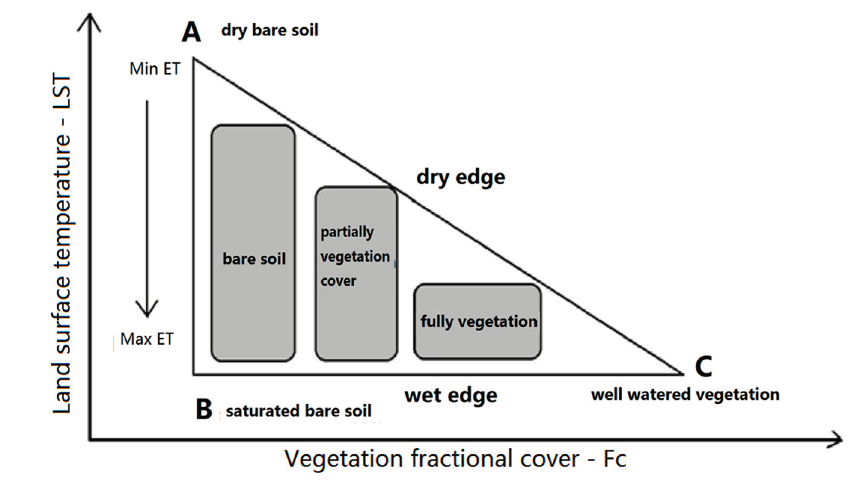
Figure 1. The concept of the LST-Fc triangular feature